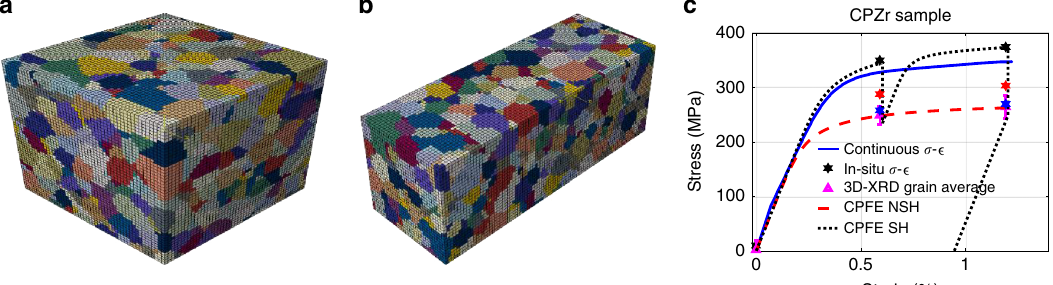
Fig. 2 Simulated microstructures and comparison between stress – strain curves. Simulated microstructures of ( a ) CPZr, and ( b ) CPTi samples. These microstructures were used for CPFE modelling. c Comparison between measured and simulated macroscopic stress – strain curve for CPZr; black, red and blue stars represent the maximum load, beginning and end of diffraction measurement for each